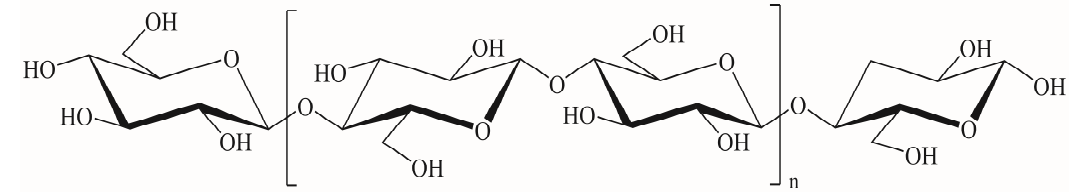
Figure 1. Cellulose molecular structure.